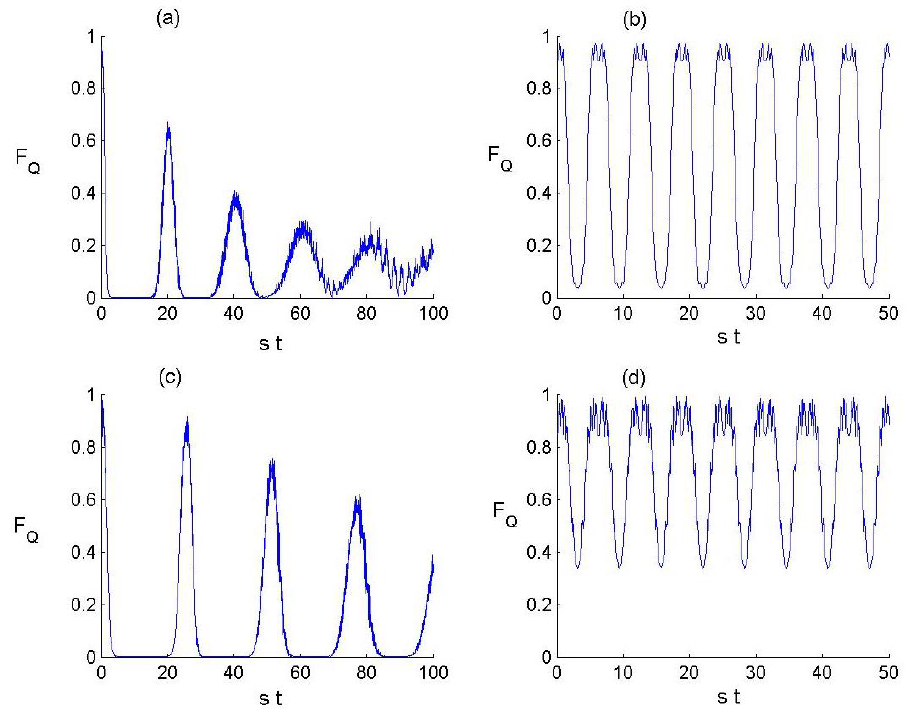
Figure 5. Time evolution of the QFI denoted by F TQS . Panels ( a , b ) correspond to the case of absence of the PDP effect (i.e., λ = 0 ) for constant ( D ( t ) = s ) and t-dc ( D ( t ) = s sin ( t )) , respectively. Panels ( c , d ) are, respectively, the same as ( a , b ) but in the presence of the PDP effect with 𝜆 = 50 .